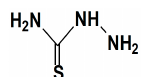
Figure 1. The structure of thiosemicarbazide.